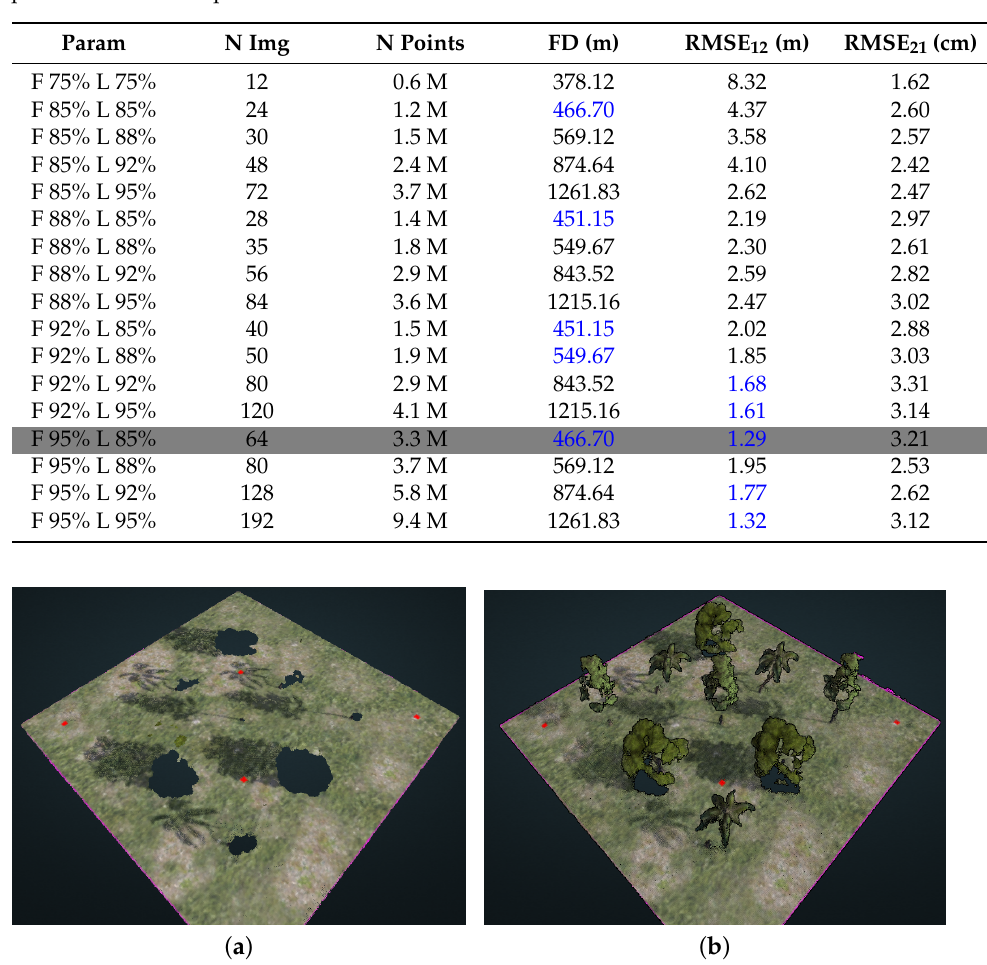
Table 1. Quality metrics for different overlaps: N Img (number of images), N Points (number of points), FD (flight distance), RMSE 21 (Root Mean Square Error) using the ground truth mesh as reference and RMSE 12 using the reconstructed cloud as reference in the estimation of RMSE. In blue, is shown the best five results for each metric, and in dark gray a good option for the trade-off between precision and overlap is remark.